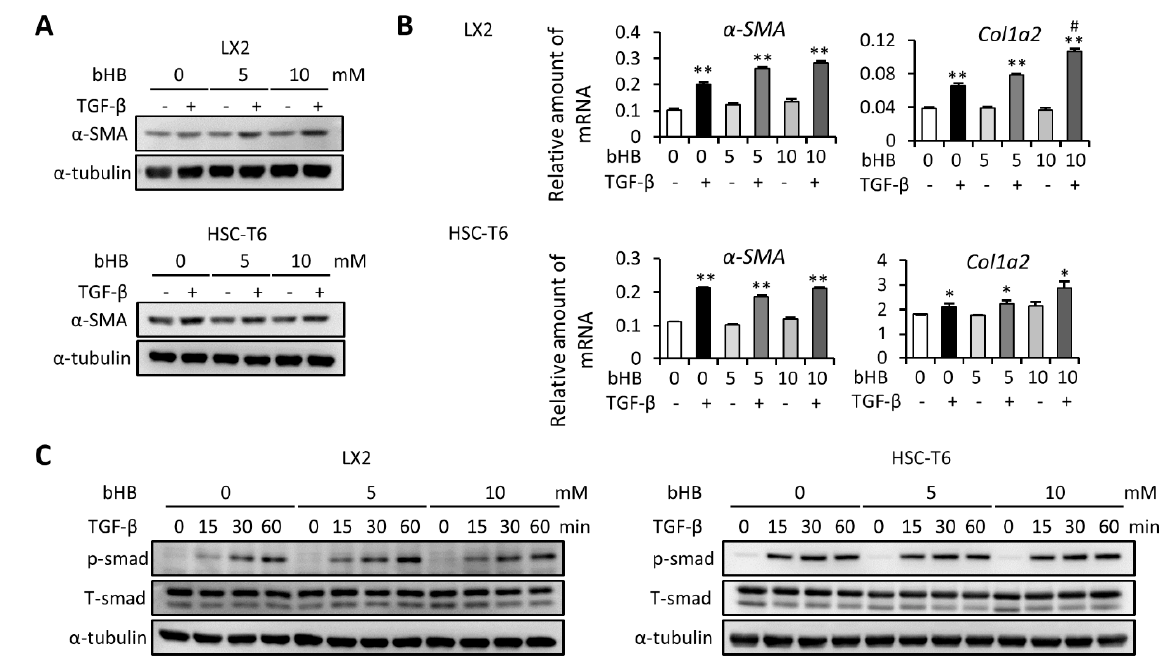
Figure 3. Effects of β -hydroxybutyrate (bHB) on TGF- β 1-induced LX2 and HSC-T6 cell activation. ( A , B ) LX2 and HSC-T6 cells were treated with 10 ng/mL TGF- β and 0, 5, or 10 mM of bHB for 24 h. Western blot and qPCR were used to evaluate the protein and mRNA expression of α -SMA and Col1a2. ( C ) LX2 and HSC-T6 cells were treated with 0, 5, or 10 mM of bHB for 24 h and then subjected to 10 ng/mL TGF- β for the indicated time periods, and the lysates were analyzed by Western blot and quantification to detect SMAD protein phosphorylation. *, p < 0.05; **, p < 0.01 vs. relative control. #, p < 0.05 vs. black bar. Data are shown as means ± SD.